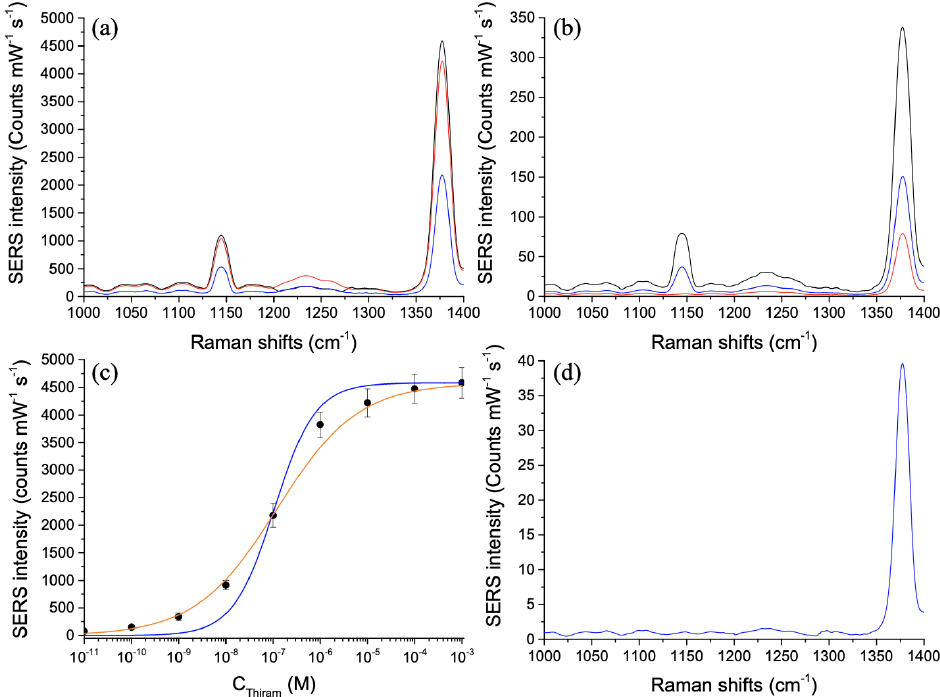
Figure 2. SERS spectra of the pesticide thiram recorded on assembled hybrid nano-urchins: ( a ) in black, C Thiram = 10 − 3 M; in red, C Thiram = 10 − 5 M, and in blue, C Thiram = 10 − 7 M; ( b ) in black, C Thiram = 10 − 9 M; in blue, C Thiram = 10 − 10 M, and in red, C Thiram = 10 − 11 M. ( c ) SERS intensity as function of C Thiram (= C S ). The black circles represent the experimental points. The blue curve represents the fitting curve with the expression of the Langmuir model. The orange curve represents the fitting curve with the expression of the Hill model. ( d ) SERS spectrum of the pesticide thiram on a 50 nm-thick gold film (without any ZnO nano-urchins) for a thiram concentration of 1 mM serving as